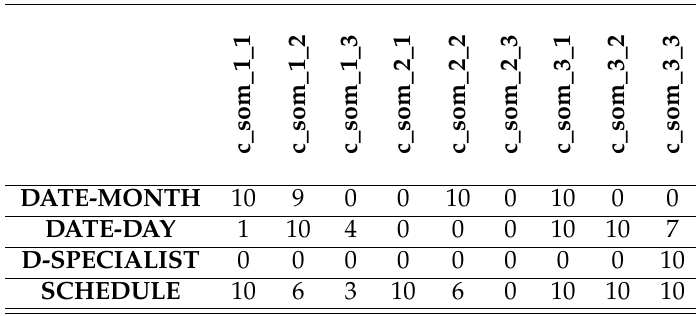
Table 4: Opposite Characteristics Grid